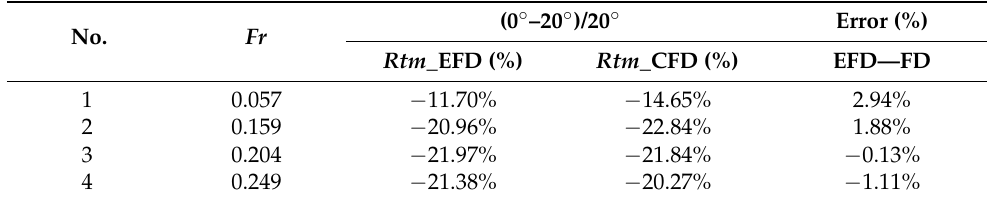
Table 5. Resistance when fins are at two